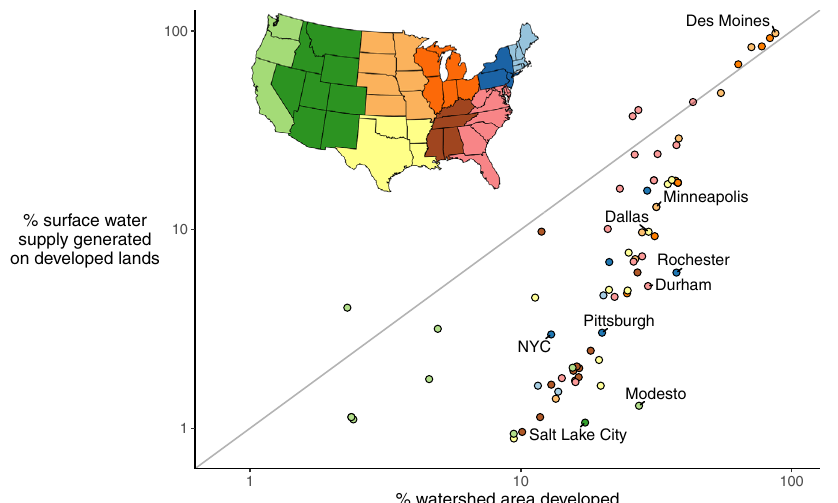
Fig. 6 Heterogeneous watershed hydrology matters. Comparison of % watershed area developed (agricultural and non-agricultural uses) against % of surface water supply generated as runoff on those developed lands. Point color gives U.S. Census division (see map